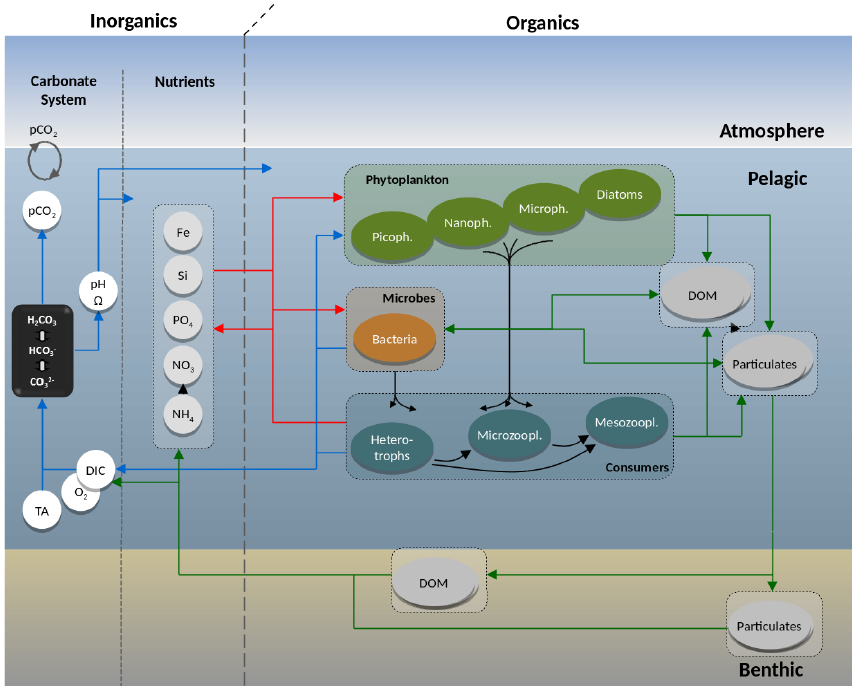
Figure 1. Schematic representing the major organisms, nutrients, chemical systems, organic matter and fluxes modelled in ERSEM. Blue connectors represent inorganic carbon, red represents nutrient fluxes, black represents predator–prey interactions and green represents the non-living